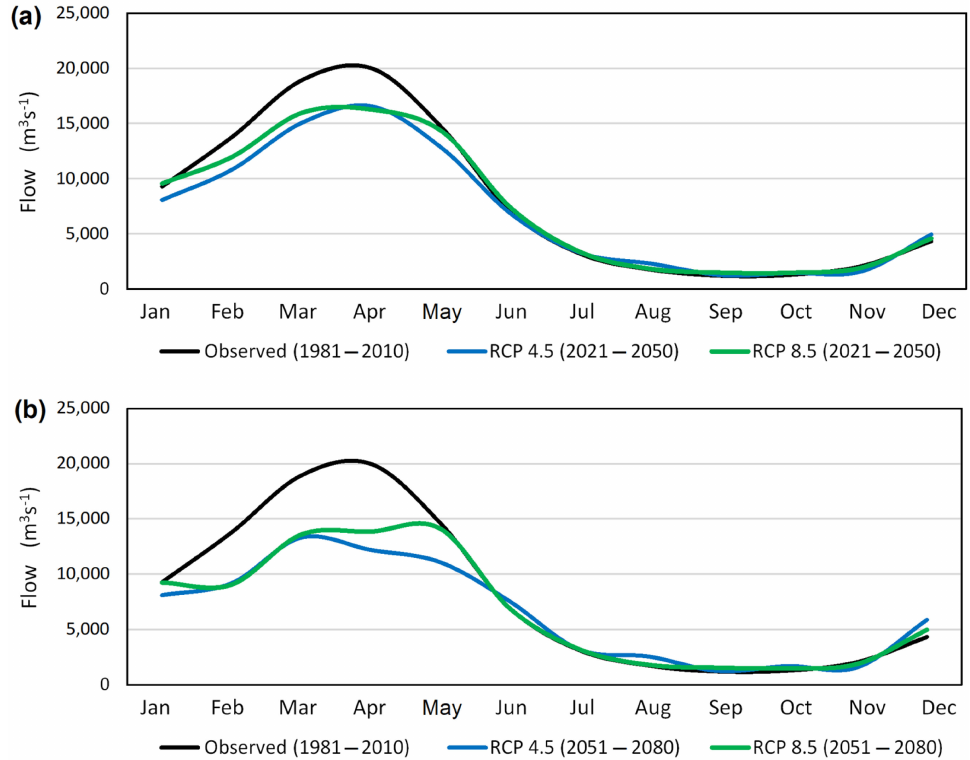
Figure 12. The observed monthly mean flow rate in the period of 1981–2010 (black) in Altamira and the ones projected for the 2021–2050 ( a ) and 2051–2080 ( b ) periods, based on the RCP 4.5 (blue) and the RCP 8.5 (green)